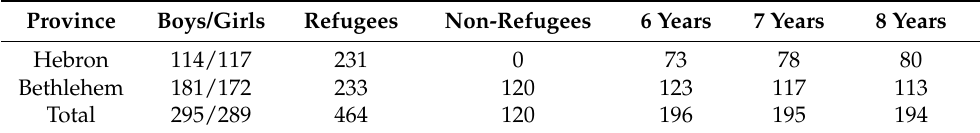
Table 1. Geographical distribution of the study